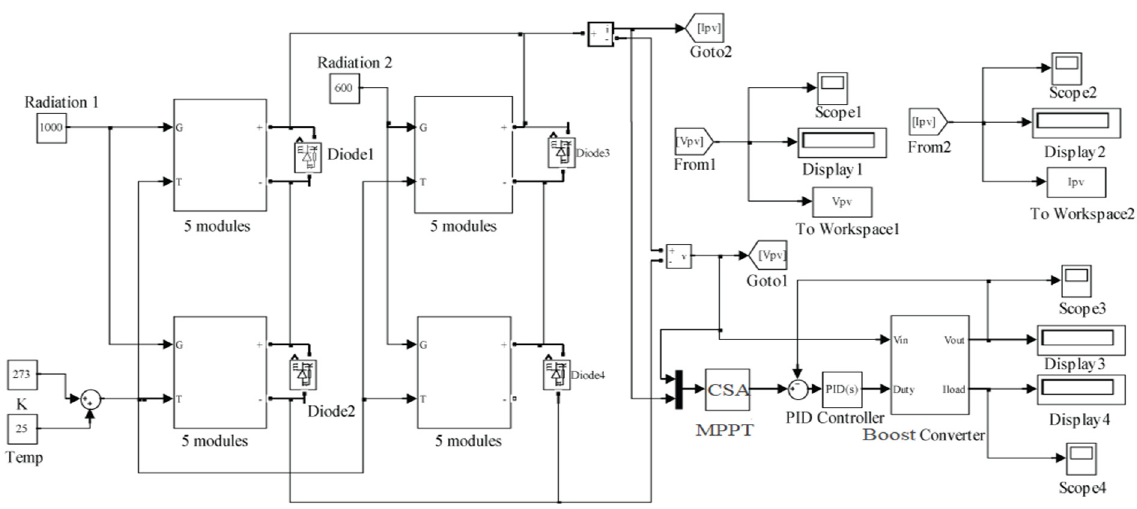
Figure 8. Modeled components of the proposed system.